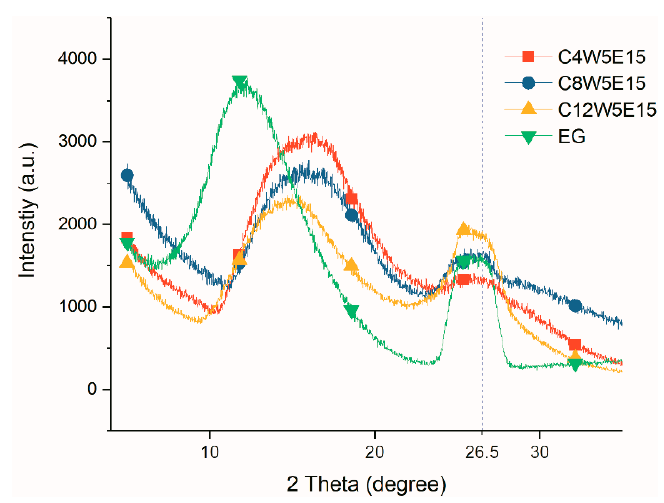
Figure 11. XRD curves of AGAs with different GO concentrations.